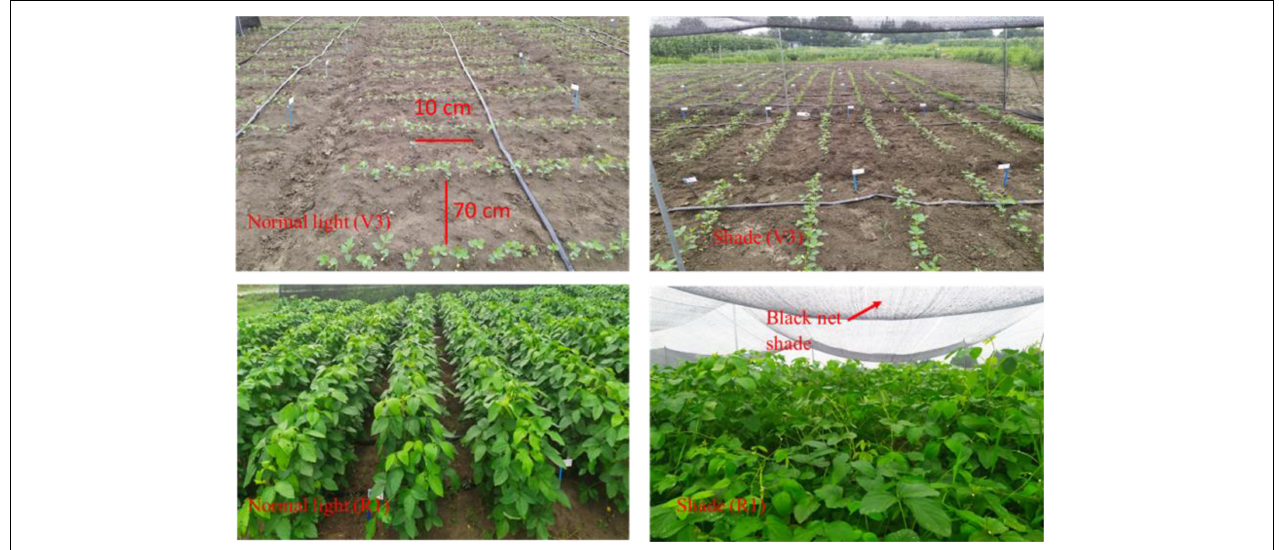
FIGURE 2 | The experiment layout of soybean plantation was shown at V3 stage (fully expanded trifoliate) and R1 stage (flowering stage) under normal light and shade conditions.